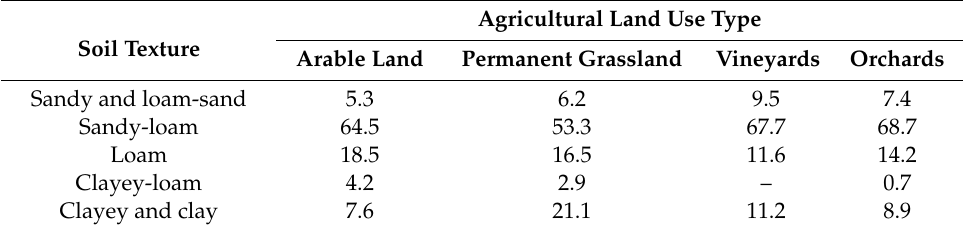
Table 5. Share of soil texture categories (%) in agricultural land use types in Slovakia.